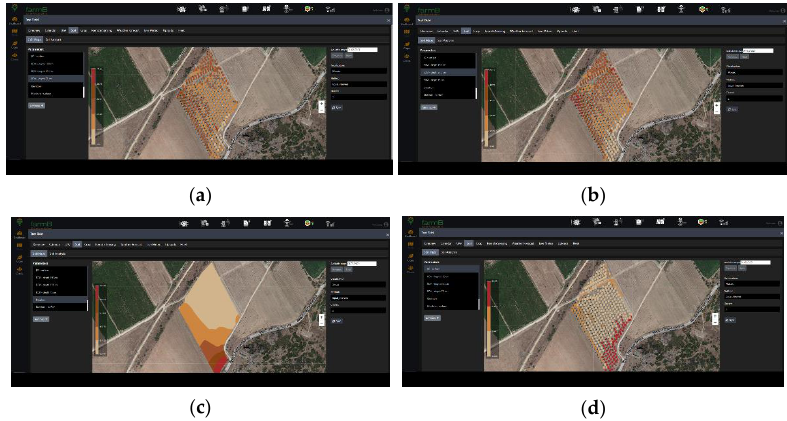
Figure 6. Field maps from farmB software interface presenting ( a ) soil ECa scanning at 0.65 m depth,